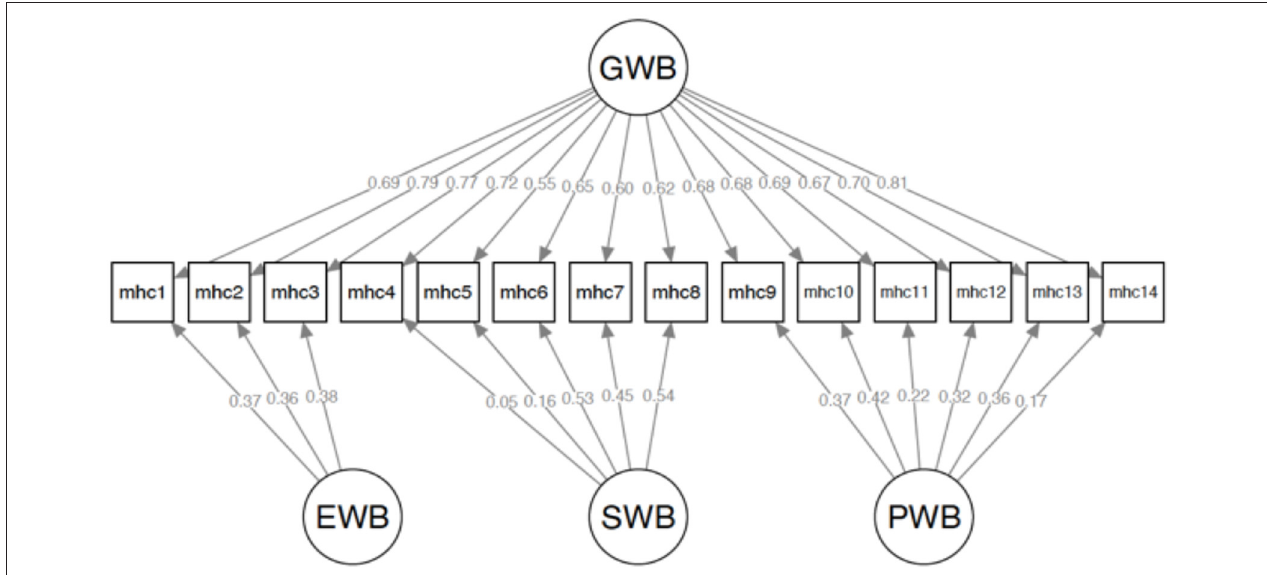
FIGURE 1 | Standardized factor loadings of the bifactor model. GWB, general well-being; EWB, emotional well-being; SWB, social well-being; PSW, psychological well-being.